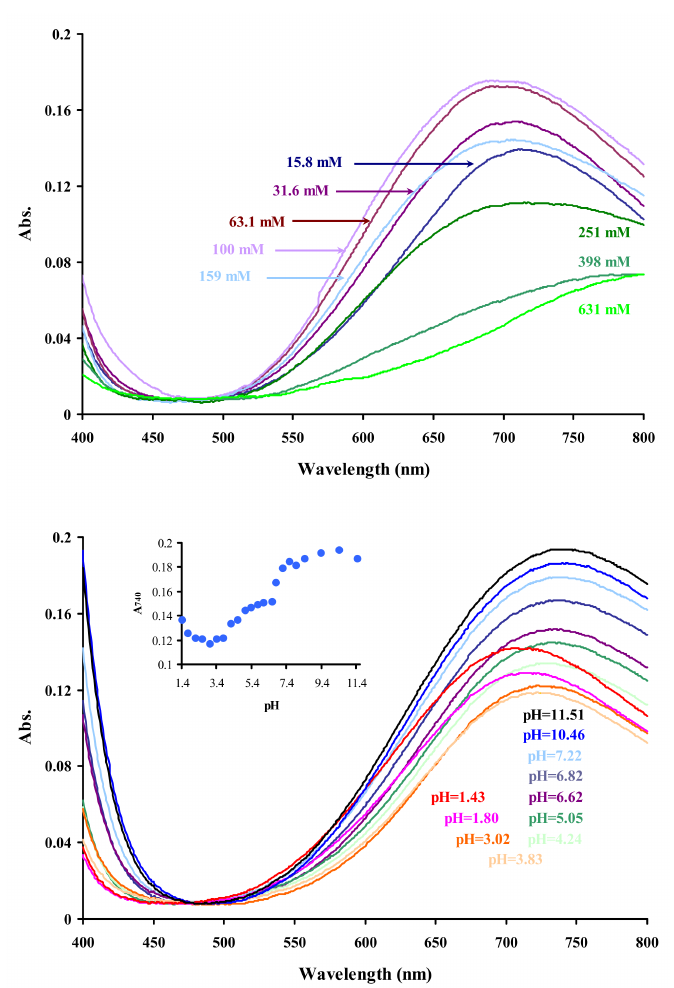
Figure 1. Absorption spectra of the Cu 2+ –DO3A-ACE 4 − –H + system ([HCl] + [NaCl] = 1.0 M; [Cu 2+ ] = [DO3A-ACE 4 − ] = 1.94 mM, l = 1 cm, 25 ◦ C). The top figure shows the batch samples pre- pared in the acid concentration range of 15.8 to 631 mM, while the other one shows the spectra obtained in the pH range of pH = 1.43 to 11.51. The insert indicates the absorbance measured at 740 nm as a function of